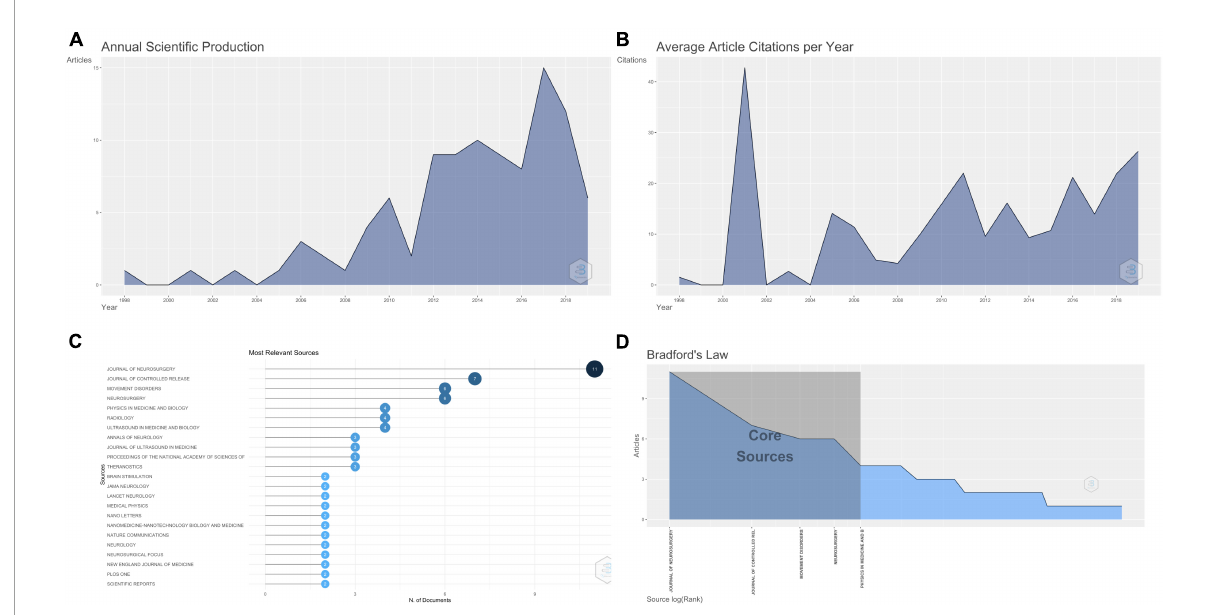
FIGURE1 (A) Line graph showing the year wise number of articles published. (B) Line graph showing the year wise average citations per year. (C) Graph showing the number of articles among the top 100 cited articles on MRgFUS published in the different journals. (D) Graphical representation of Bradford’s